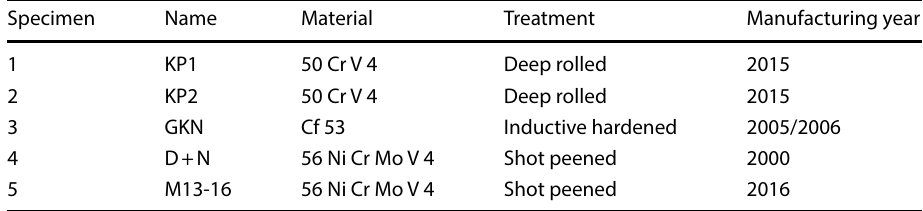
Table 1 Specimen